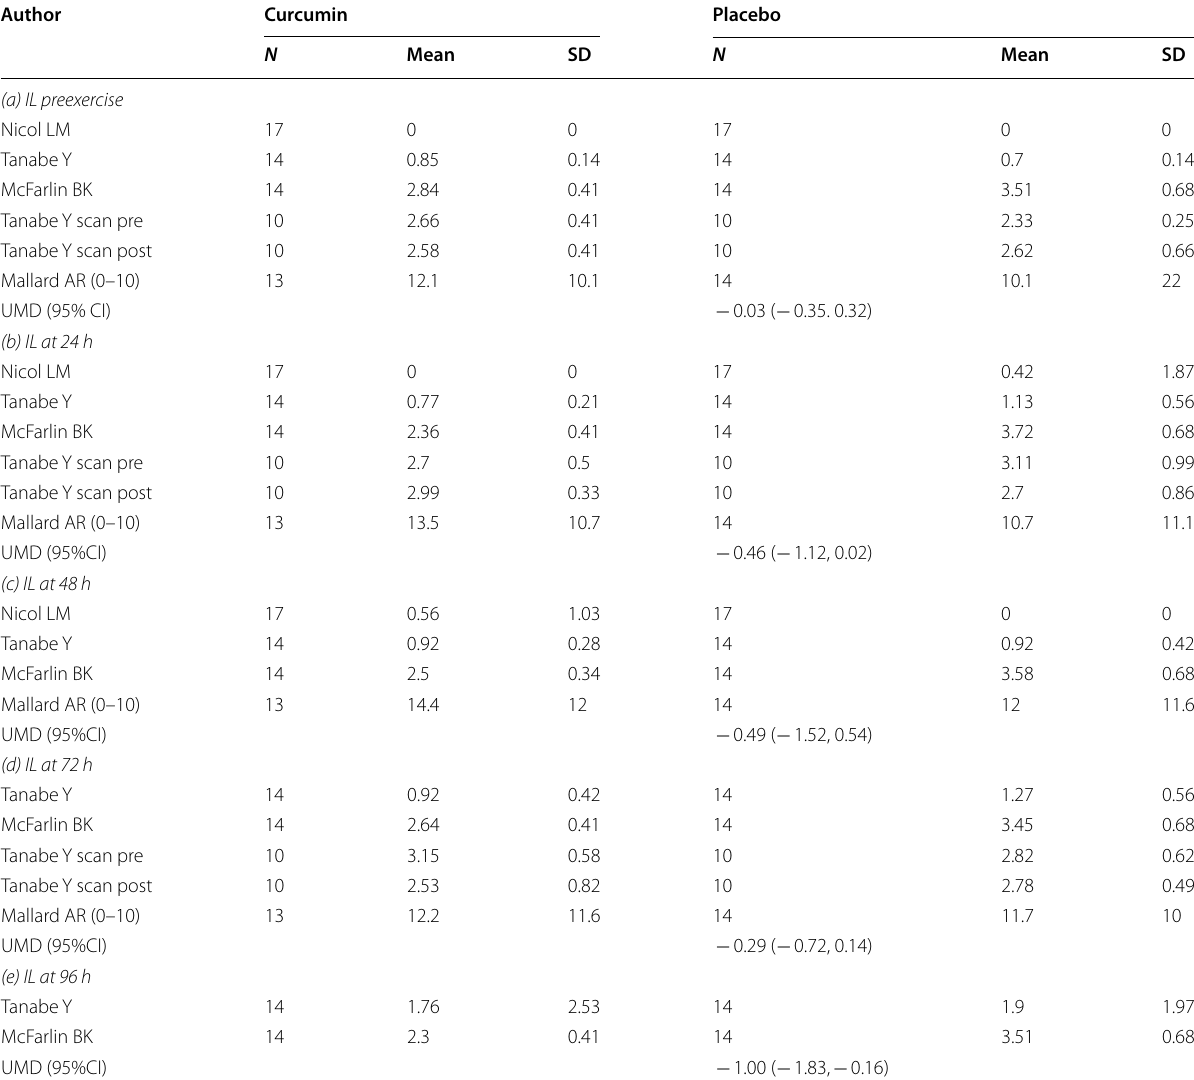
Table 6 Comparisons of IL between curcumin supplement and